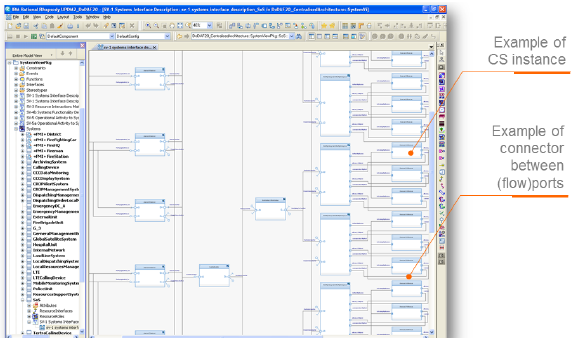
Figure 10. SoS architecture in